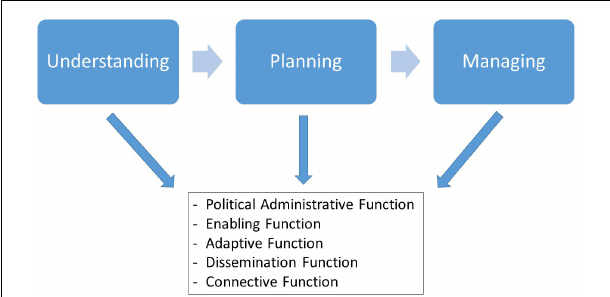
FIGURE 2 | Leadership functions throughout the three phases of the policy process – the political administrative function, enabling function, adaptive function, dissemination function, and connective function are facilitated by